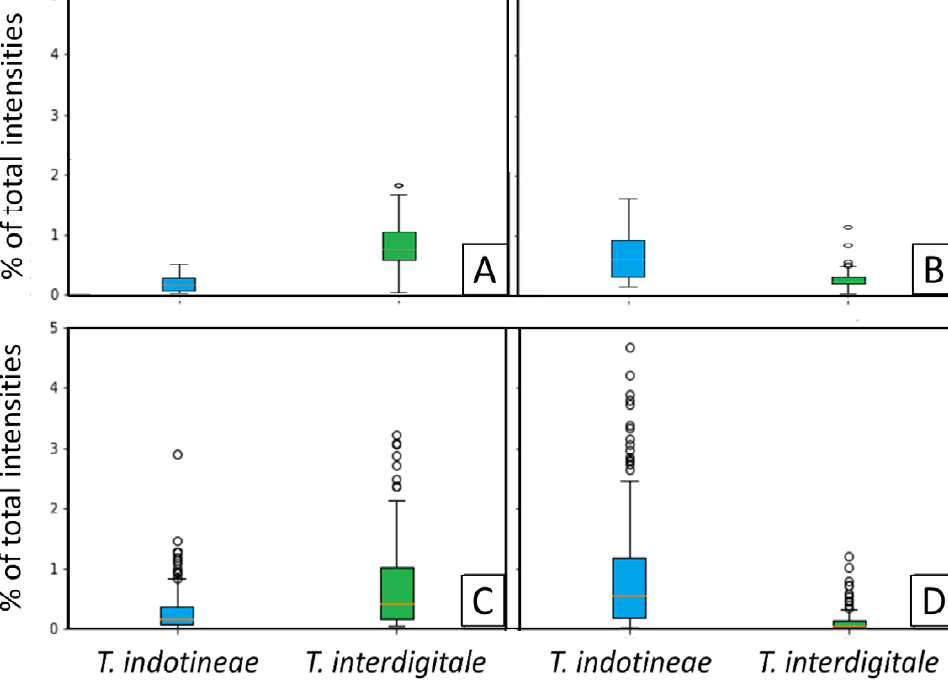
Figure 3. Distribution of the percentages of the intensities corresponding to one specific peak compared to the overall intensities of the spectrum at 10 days of growth. T. indotineae plots are colored blue, and T. interdigitale genotype II plots are colored green. ( A ) = peak at 6834 ( ± 5) daltons (Da), ( B ) = peak at 6845 ( ± 5) Da, ( C ) = peak at 10,634 ( ± 10) Da, and ( D ) = peak at 10,680 ( ± 10) Da.